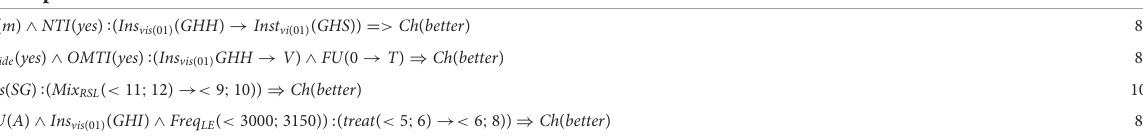
TABLE 5 Results on actionable knowledge discovery for recommending treatment in TRT. A sample treatment action rule Conf.